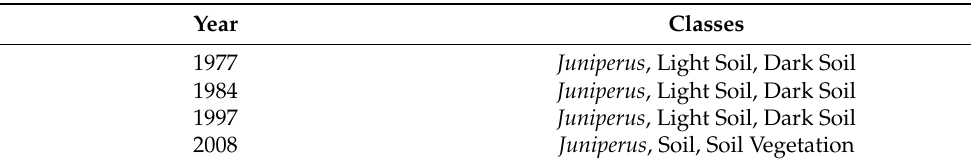
Table 2. Classes used in the image classifications. Juniperus : individuals of Juniperus communis . Light soil: patches of soil with high brightness. Dark soil: patches of soil with low brightness. Vegetation soil: patches of soil with small vegetation.